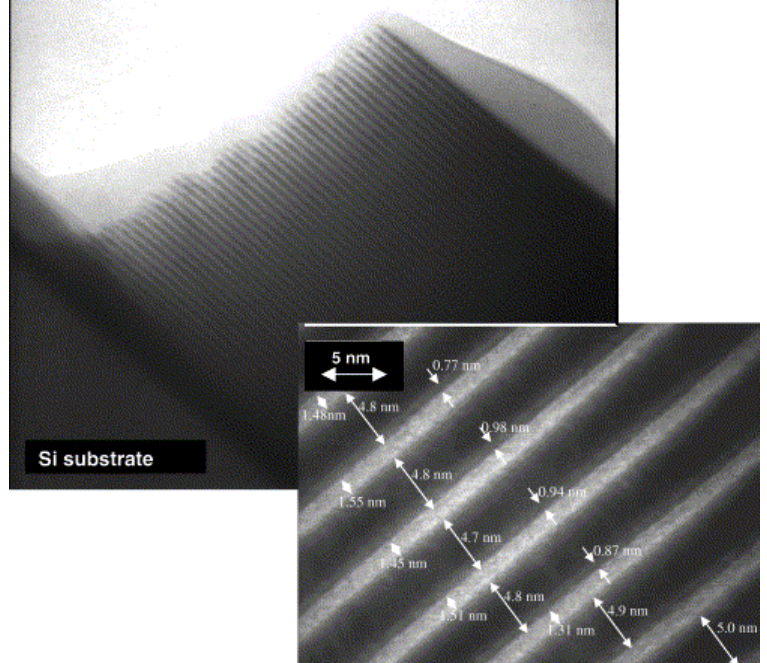
Figure 16 . Cross-section TEM micrograph of a Mo/Si multilayer stack formed by dual ion beam assisted deposition. The inset shows in detail the thickness of the Si-layer (dark), the Mo-layer (bright) and the interface between Si and Mo. Reprinted from [34], Copyright 2002, with permission from